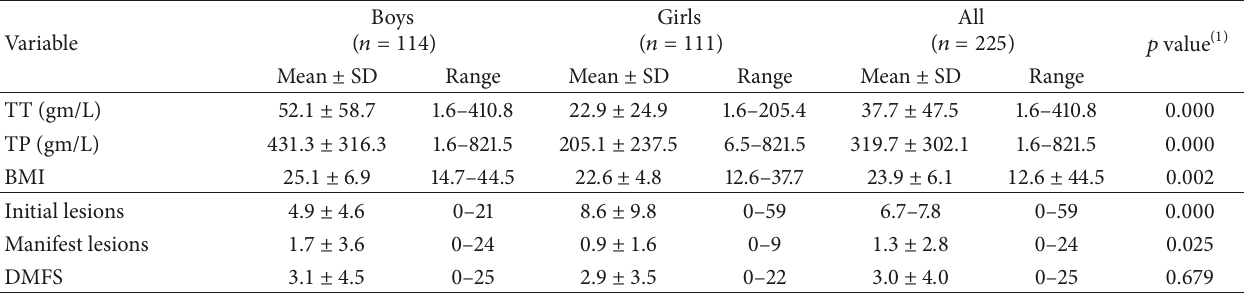
Table 5: Mean and standard deviation (SD) for sweet taste threshold (TT), sweet taste preference (TP), BMI, initial, manifest lesions, and DMFS in Saudi schoolchildren (boys,